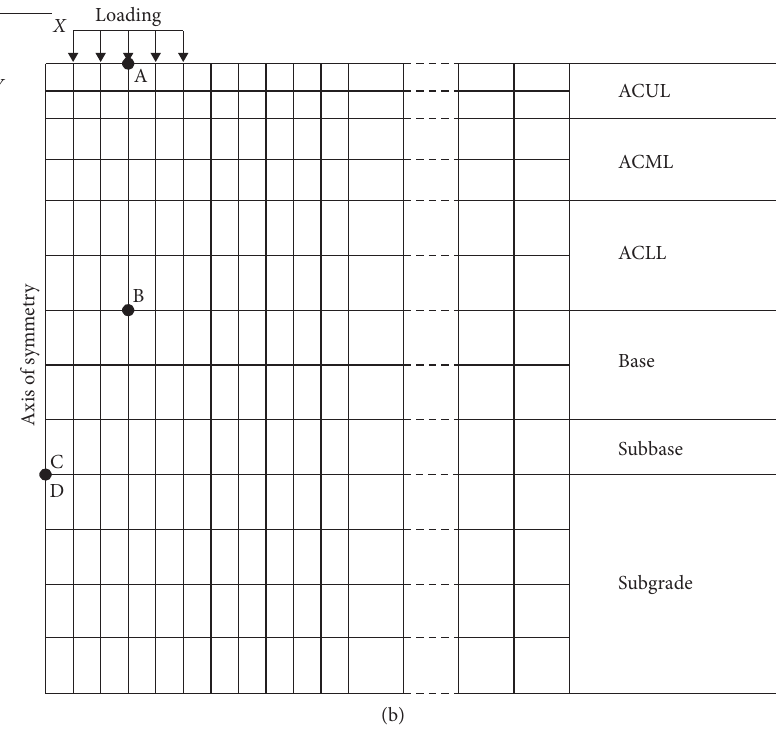
Figure 2: (a) Loading areas and mesh (not to scale). (b) Mesh and calculated points (not to